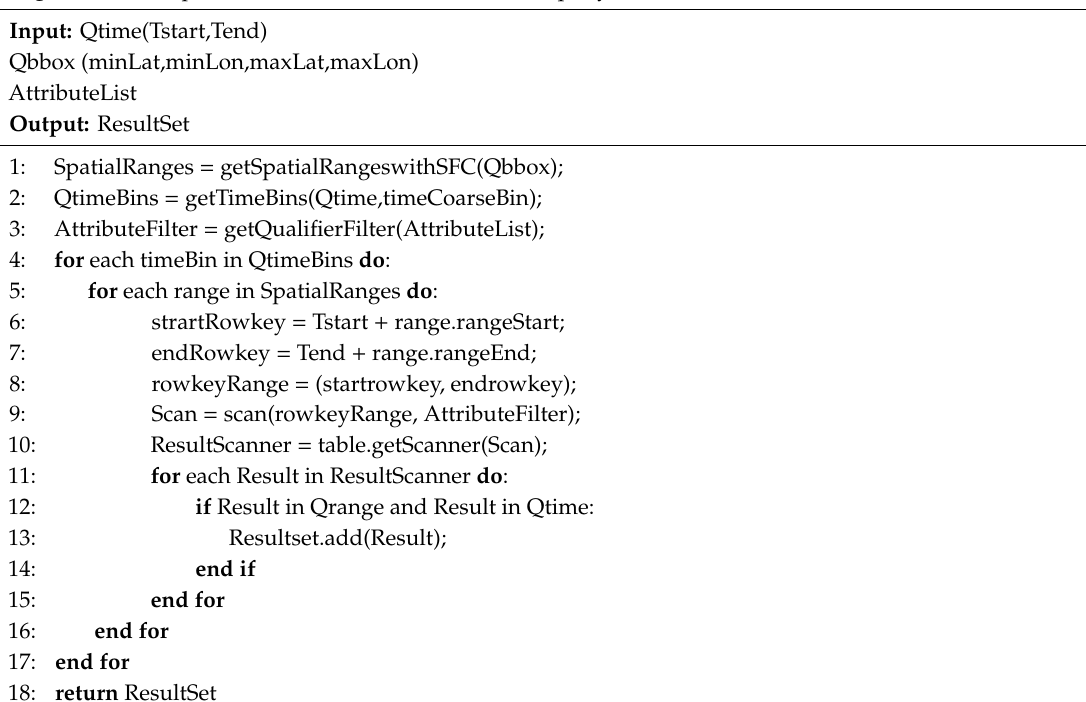
Algorithm 2 The pseudocode of the multidimensional query in